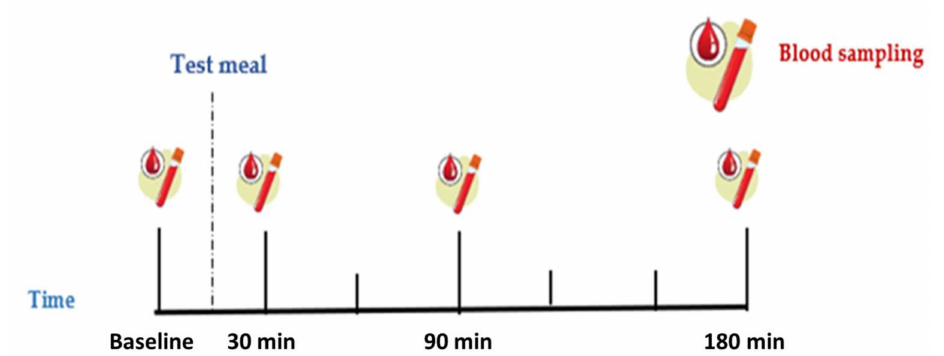
Figure 1. Test visit flow